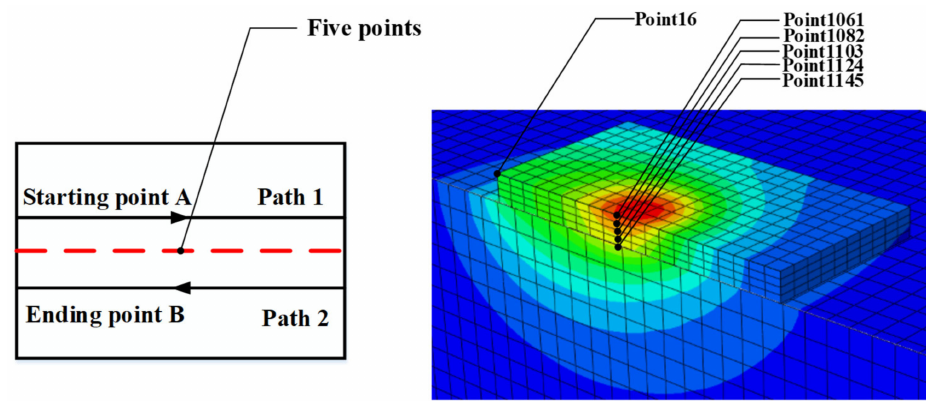
Figure 4. Node and center line